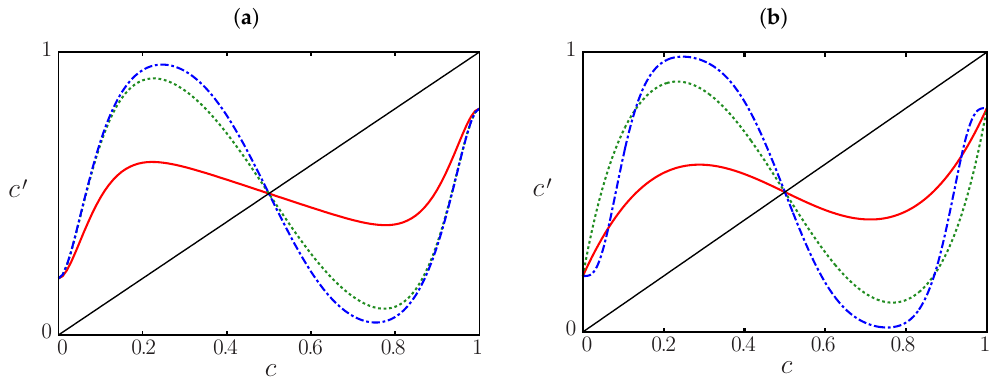
Figure 11. ( a ) Graphs of the mean field map corresponding to Equation (8) for different values of J and k = 20. From bottom to top for c < 1/2, J = 0.5 (red, lower line), J = 3.0 (green, middle − − line), and J = 6.0 (blue, upper line). ( b ) Graphs of the mean field approximation for Equation (8) for − different values of k and J = 6. From bottom to top, for c 0.2, k = 4 (red, lower line), k = 10 (green, − ∼ middle line), and k = 38 (blue, upper line). Figures from [74].